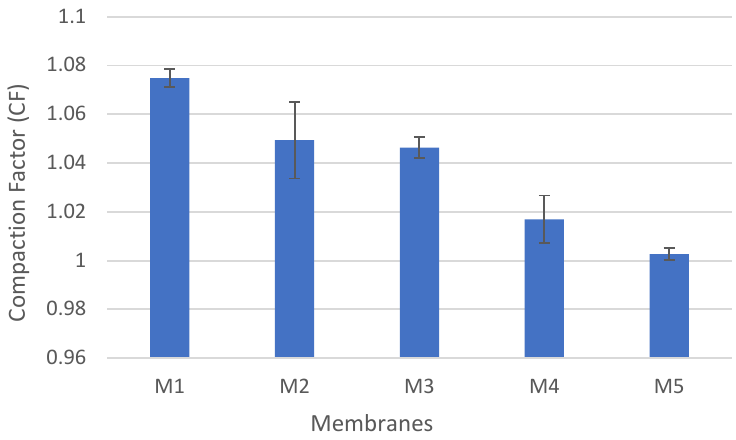
Figure 16. The CF values for PSF/CNF membranes at an operating pressure of 10 bar.